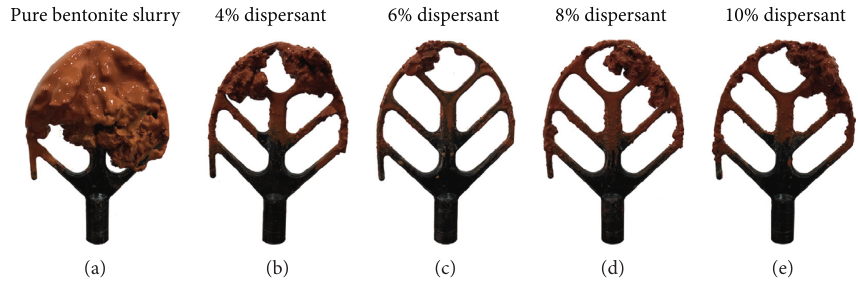
Figure 9: Clay sticking to the beater at c � 1.40 g/cm 3 .